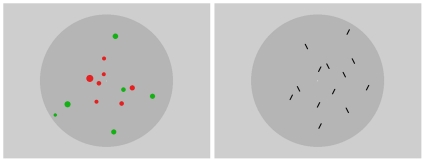
Stimulus configurations in the two experiments.Schematic view of stimulus configurations used in the numerosity discrimination experiment using color (left panel) or orientation (right panel) as a distinctive attribute.